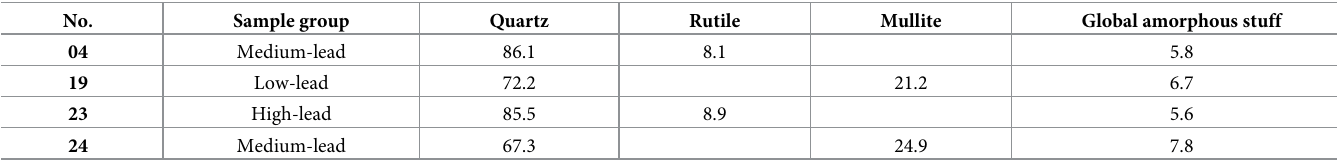
Table 4. The XRD test results of the ceramics bodies